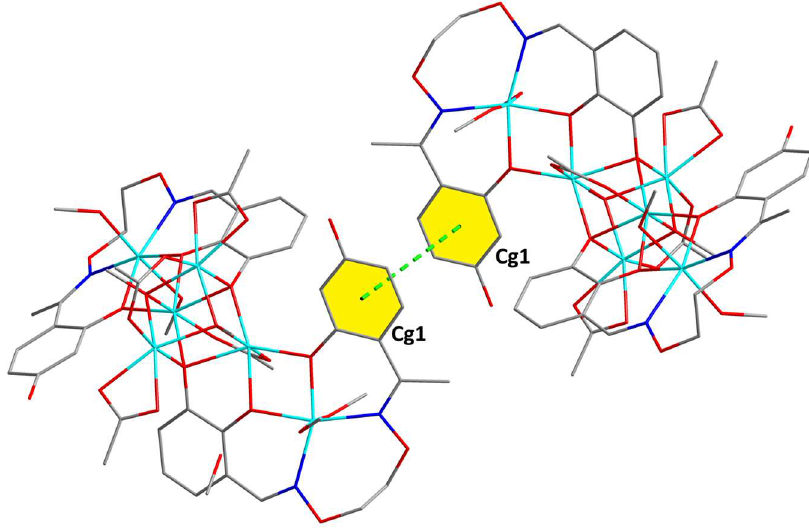
Figure 3. π···π stacking interactions of the Co(II) coordination compound.